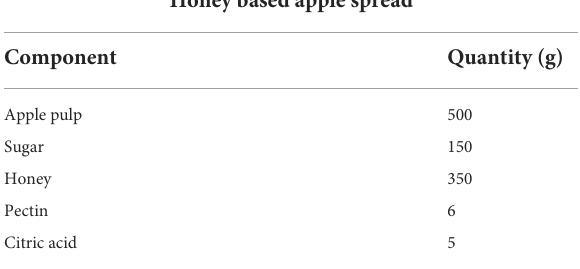
TABLE 1A Formulation of honey based apple spread and